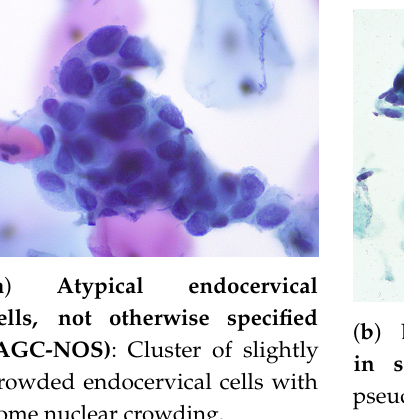
Figure 3. Atypical glandular cells on LBC. From: Nayar, R.; Wilbur, D. The Bethesda System for Reporting Cervical Cytology: Definitions, Criteria, and Explanatory Notes , 3rd ed.; Springer International Publishing, 2015 [26] and reproduced with permission of